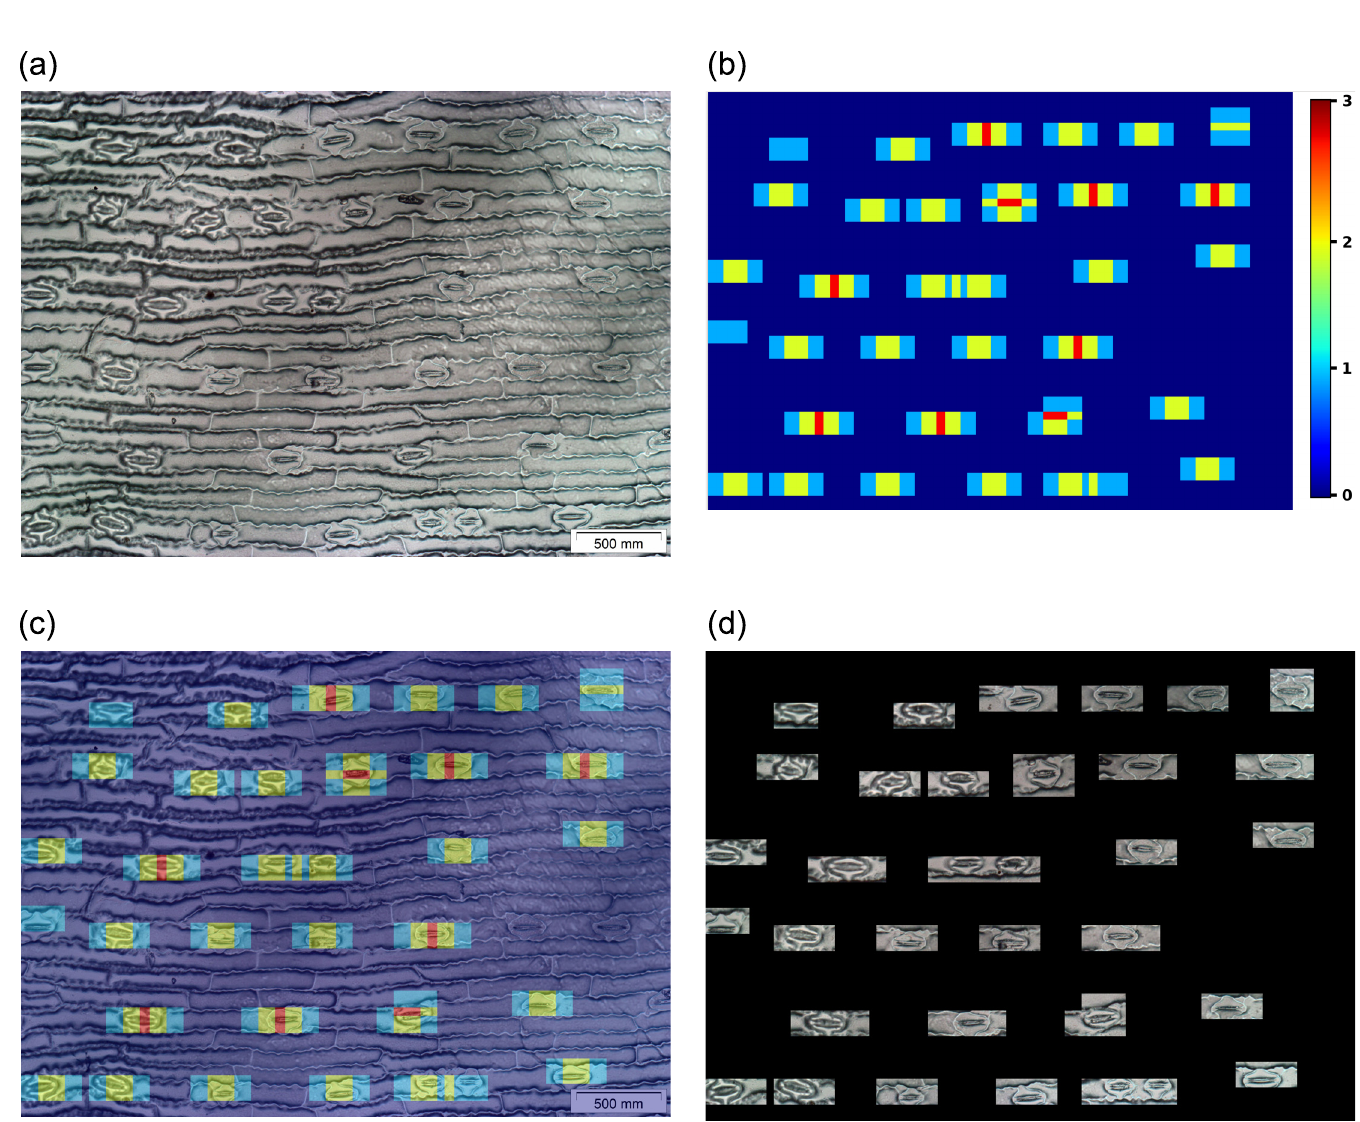
Fig 8. Heatmap representation of the system performance. Based on the sliding window mechanism applied to the original microscope image (a), different regions were considered as containing stomata (b) and used as an image mask (c) for image segmentation (d).